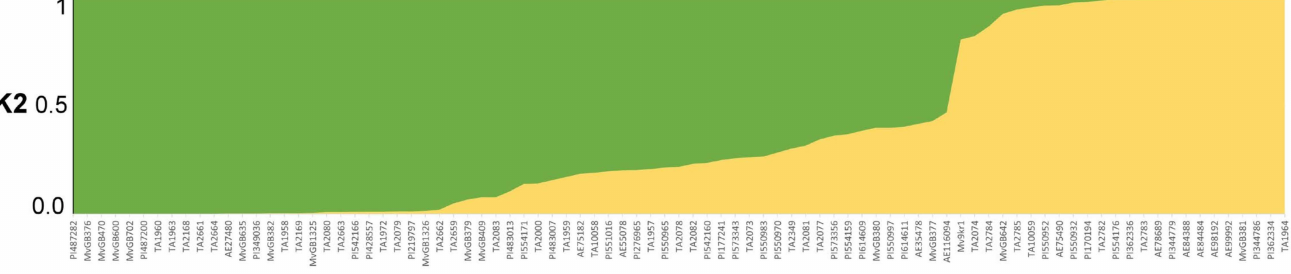
Figure 3. STRUCTURE bar plot for K = 2 based on genotyping data of DArTseq-derived SNP markers. Q value represents the proportion of ancestry to a given